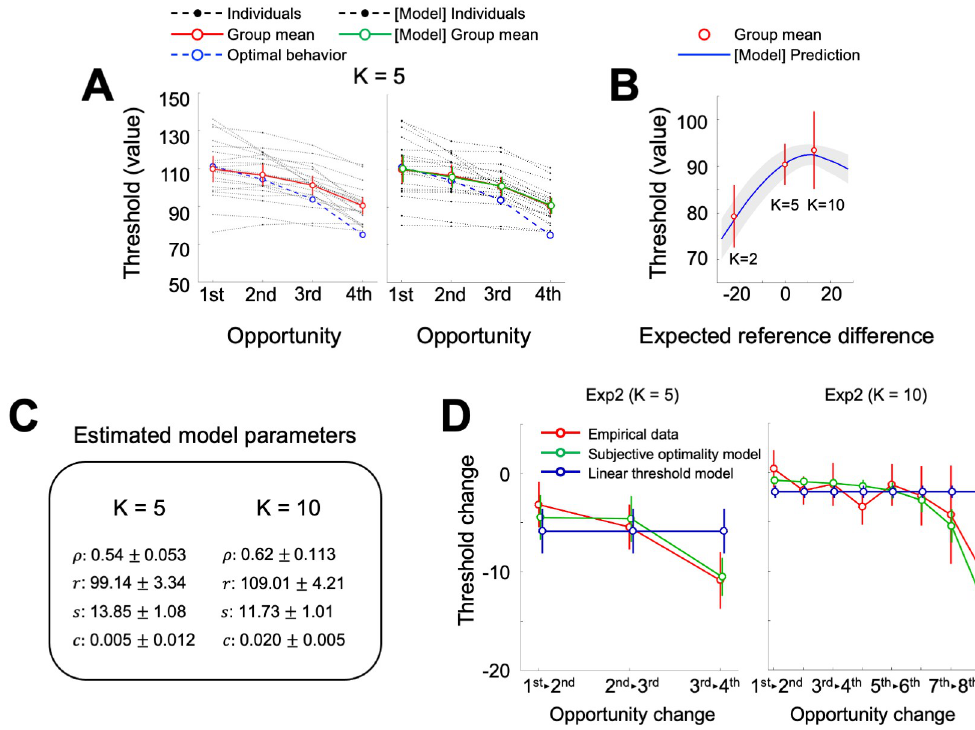
Fig 3. Behavioral results of Experiment 2. (A) In individuals who had five opportunities (K = 5), empirical decision thresholds (red) along the opportunities were comparable with that of Experiment 1. (B) To examine whether or not our Subjective optimality model can be generalized to other contexts, a model prediction of the decision threshold was made for K = 2 and 10; value sensitivity was assumed to be the same even in the different context, but the reference point was adjusted proportionately to the changes of the expected payoff. Empirical (observed) decision thresholds (red) at the opportunity preceding the last in the condition with two (K = 2), five (K = 5), or ten (K = 10) opportunities were consistent with the prediction (blue). Error bars represent 95% confidence interval. (C) Model parameters were estimated using the Subjective optimality model with a waiting cost. The parameters cannot be estimated for K = 2, because there is only one valid opportunity per round for each individual. (D) The pattern within the decision curve (c hange in the slope of decision threshold) was consistent in both of the Exp 2 data, and our Subjective optimality model successfully explained the pattern (differences between the model and empirical data do not vary across opportunities; Exp2 (K = 5): F(2, 40) = 2.37, η 2 = 0.11, p = 0.11; Exp2 (K = 10): F(7, 119) = 0.67, η 2 = 0.039, p = 0.70), and has superior explanatory power to the linear threshold model. Negative values on the y-axis indicate that decision thresholds decrease between opportunities. Error bars indicate